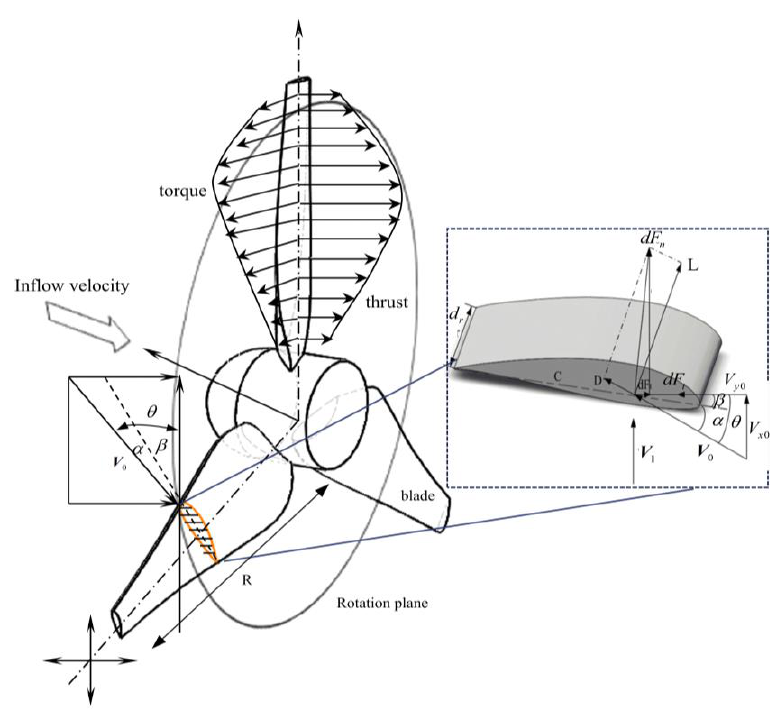
Figure 1. Velocity triangle and force analysis of blade element